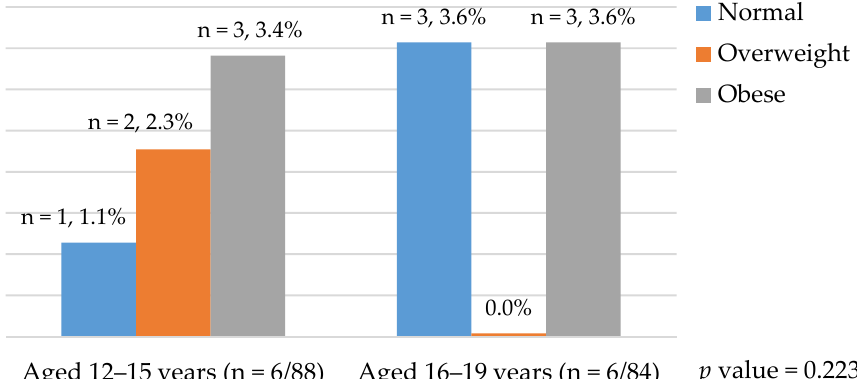
Figure 1. Prevalence of metabolic syndrome (MS) by age and body mass index (BMI).